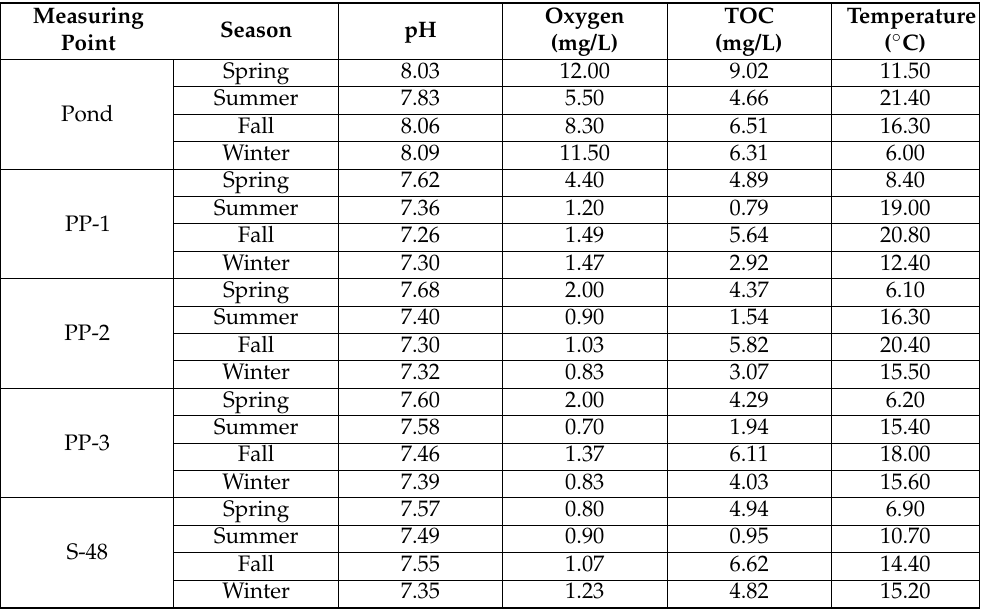
Table 4. The average season values of water quality parameters measured at measuring points during the research